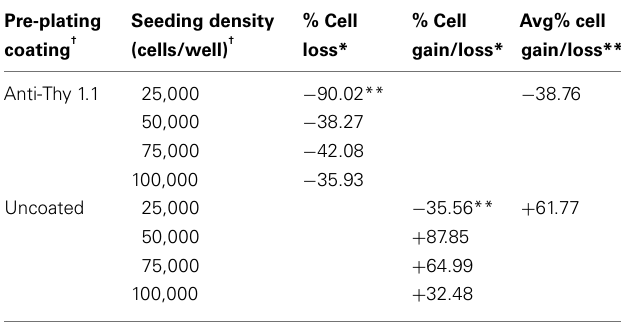
Table 1 | Efficiency of pre-plating DRG neuron suspensions on coated and uncoated 60mm culture dishes at support cell